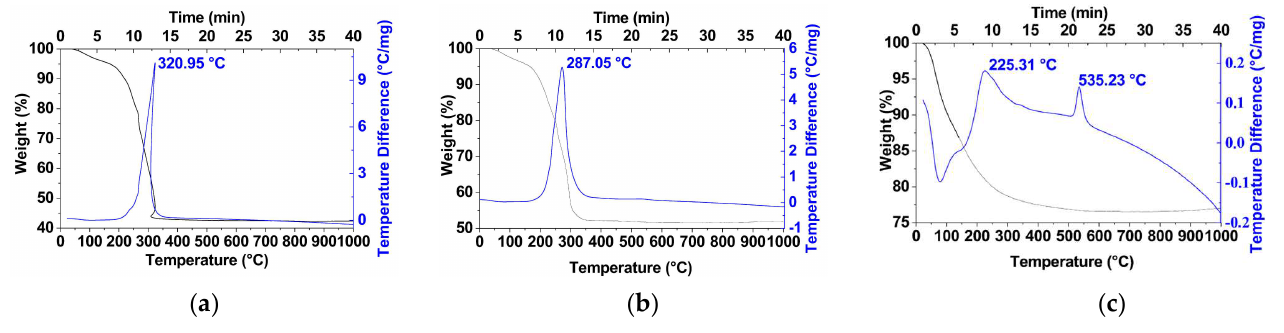
Figure 4. TGA (black curve) and DSC (blue curve) curves for the as-prepared samples with dextran-40 ( a ) and inulin ( b ) and without polysaccharides ( c ). The maximums on the DSC curves correspond to complete oxidation of the adsorbed polysaccharide.